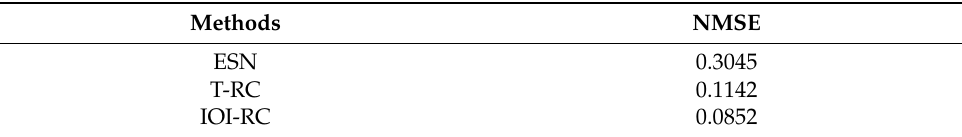
Table 1. Performance comparation of NARMA10